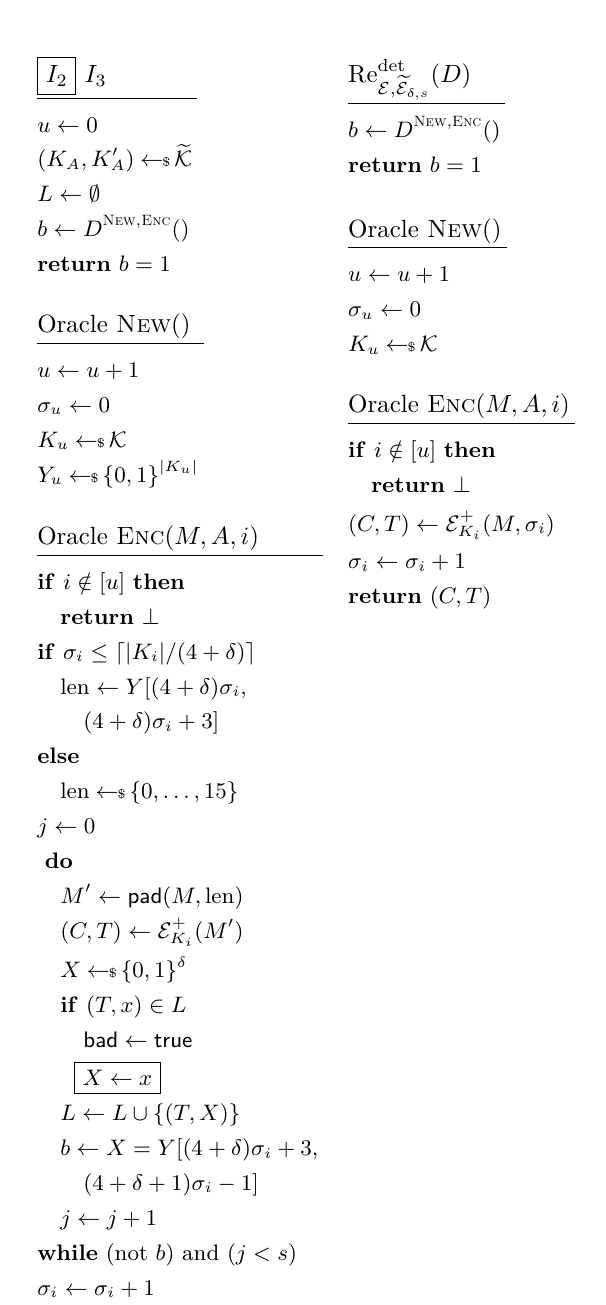
( D ) used in the proof from Section E , e E δ,s